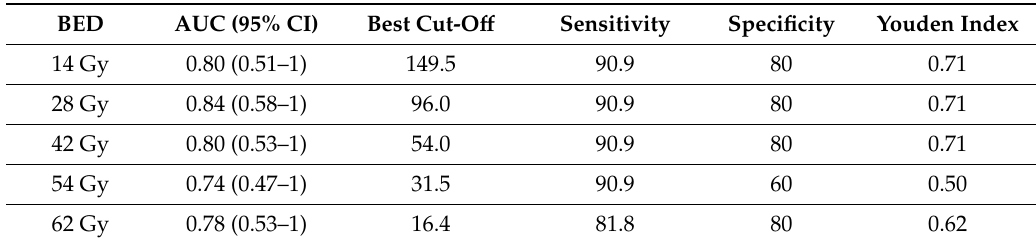
Table 4. Indicators of the predictive performance of the early regression index (ERI TCP ) index in the case of cervical cancer at di ff erent BED levels.